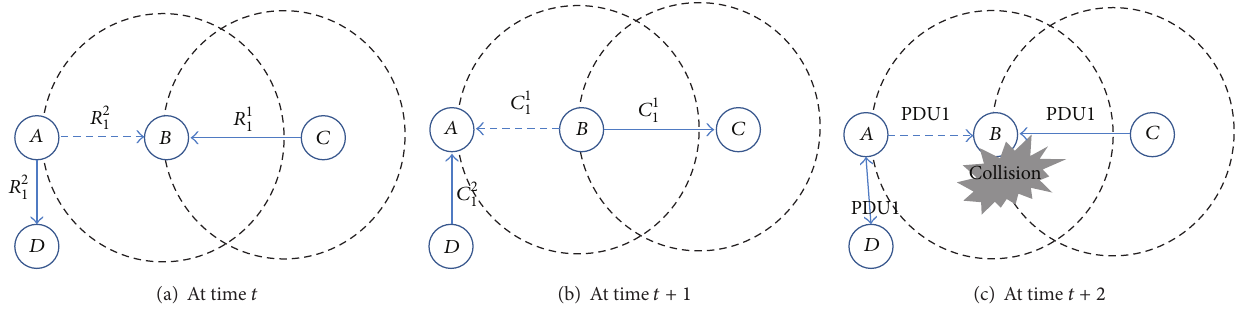
Figure 3: An example of operational procedure for a node to detect and treat an LET2. (In the following figures, we use frame time units. A circle represents the transmission range of a node located at the center of the circle. The solid arrows represent the intended direction of a frame and the dotted arrows represent the propagation of a frame to the nodes that are not the destinations of the frame. PDU 𝑥 denotes data sent through PDU bin 𝑥 .)